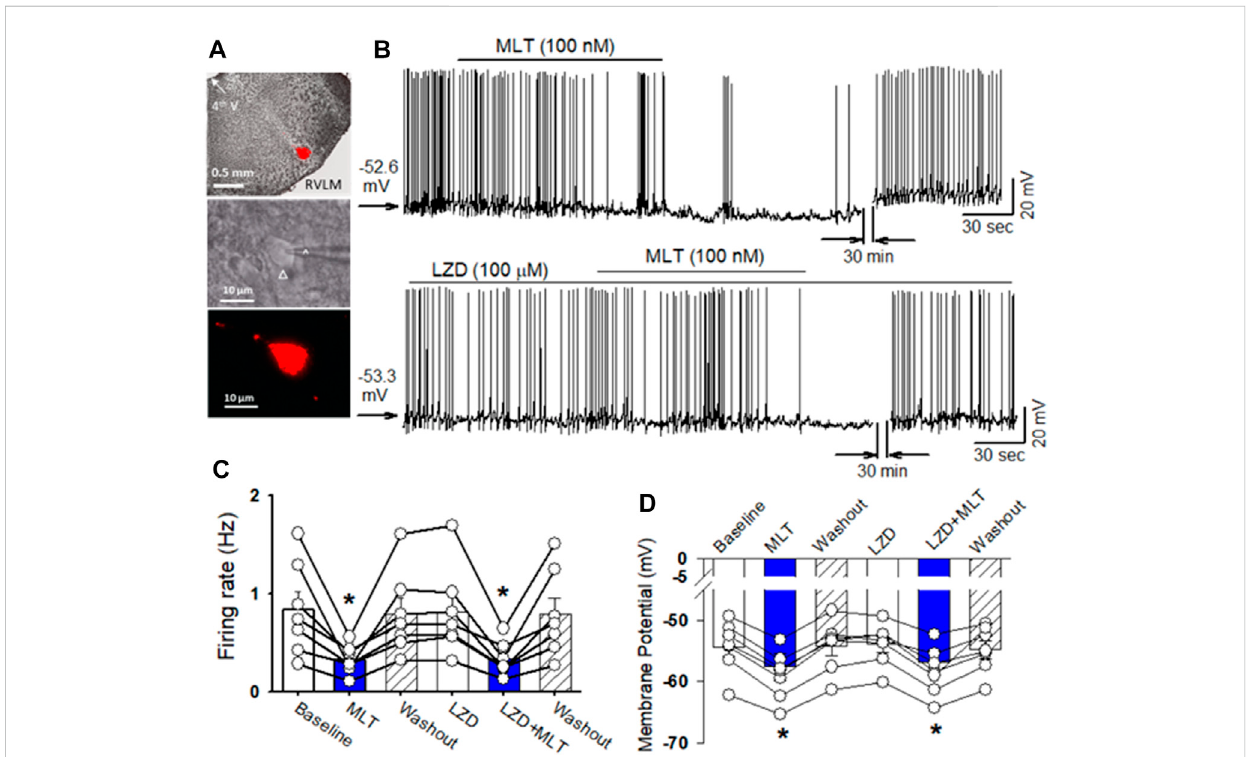
Melatonin reducedthe fi ringactivityofRVLMprojectingPVNneurons. (A) ,microphotography (upper panel)andFluoSphere-labeled PVNneuron(*) in brain slice viewed with and infrared differential interference contrast optics (middle panel) and fl uorescence illumination (lower panel). The recording electrode was markedwith anarrow. (B) ,upperpanel: Representative rawtracingsshow that bathapplicationofmelatonin (100 nM) decreasedthe fi ring activity of RVLM projecting PVN neurons. Lower panel: MT receptor antagonist luzindole (100 μ M) did not alter the baseline fi ring activity and melatonin-induceddecreaseinthe fi ringactivityofRVLMprojectingPVNneurons. (C) and (D) ,Summarydataof fi ringrats (C) andmembranepotential (D) show melatonin decreased the spontaneous fi ring rats and hyperpolarized the labeled RVLM projecting PVN neurons in both vehicle and MT